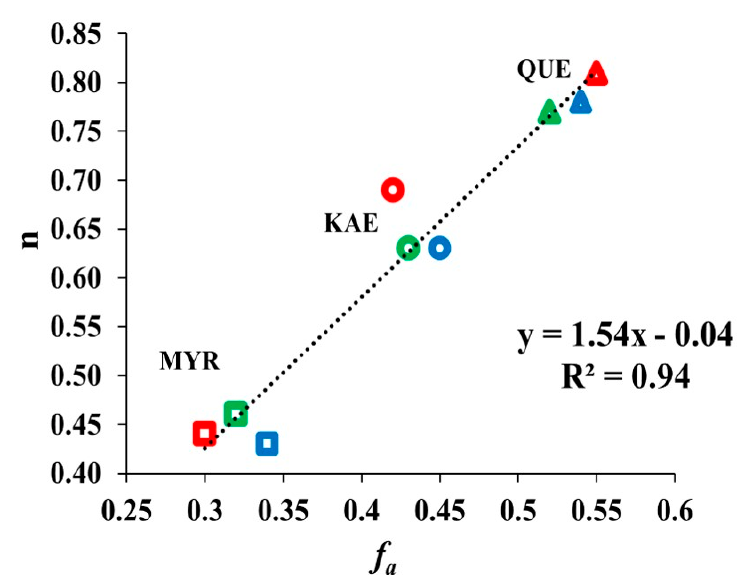
Figure 8. Relationship between the W accessible factor ( f a ) and the binding sites (n) of the three flavonols recorded at three temperatures: 298 K (blue), 308 K (green), 318 K (red). KAE, kaempferol; QUE, quercetin; MYR, myricetin represented by a circle, triangle and square, respectively.